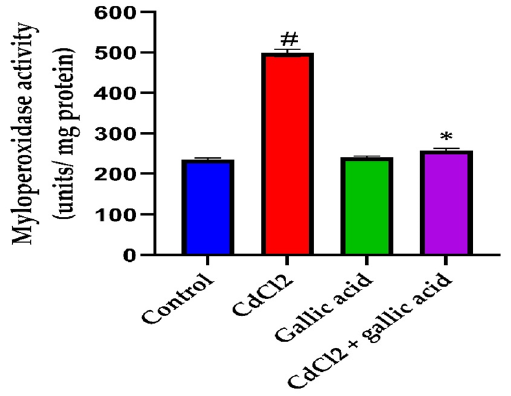
Figure 5. Gallic acid reverses brain cerebrum myeloperoxidase activity in CdCl 2 -induced neurotoxicity in Wistar rats. The data is represented as mean ± SD (n = 5). # Significant at p < 0.05 compared to the control; *Significant at p < 0.05 compared to CdCl 2 alone and CdCl 2 + gallic acid.